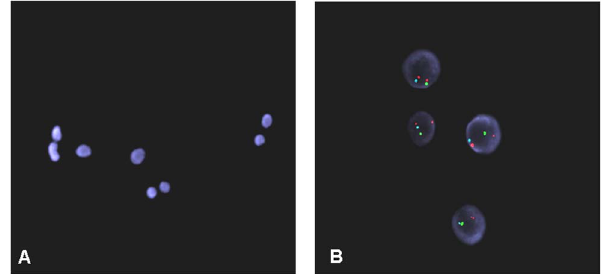
Figure 2. Cells obtained by biopsy for PGD. (A) Fixed nuclei stained with DAPI. (B) FISH signals for chromosome 21 (orange), the Y- chromosome (aqua), and the X-chromosome (green). doi:10.1371/journal.pone.0106433.g002 PLOS ONE |